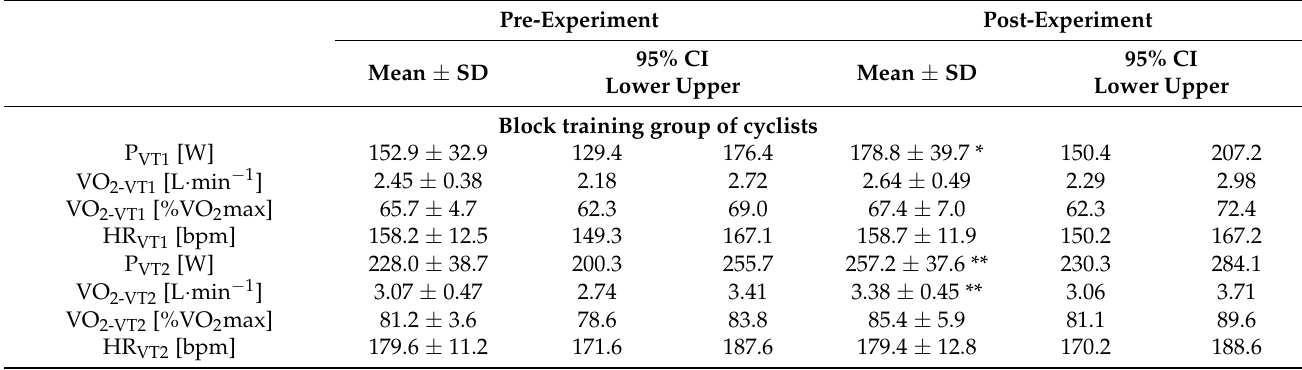
Table 3. Power, oxygen uptake, and heart rate achieved at ventilatory thresholds before and after the experiment in the block training group and the polarized training